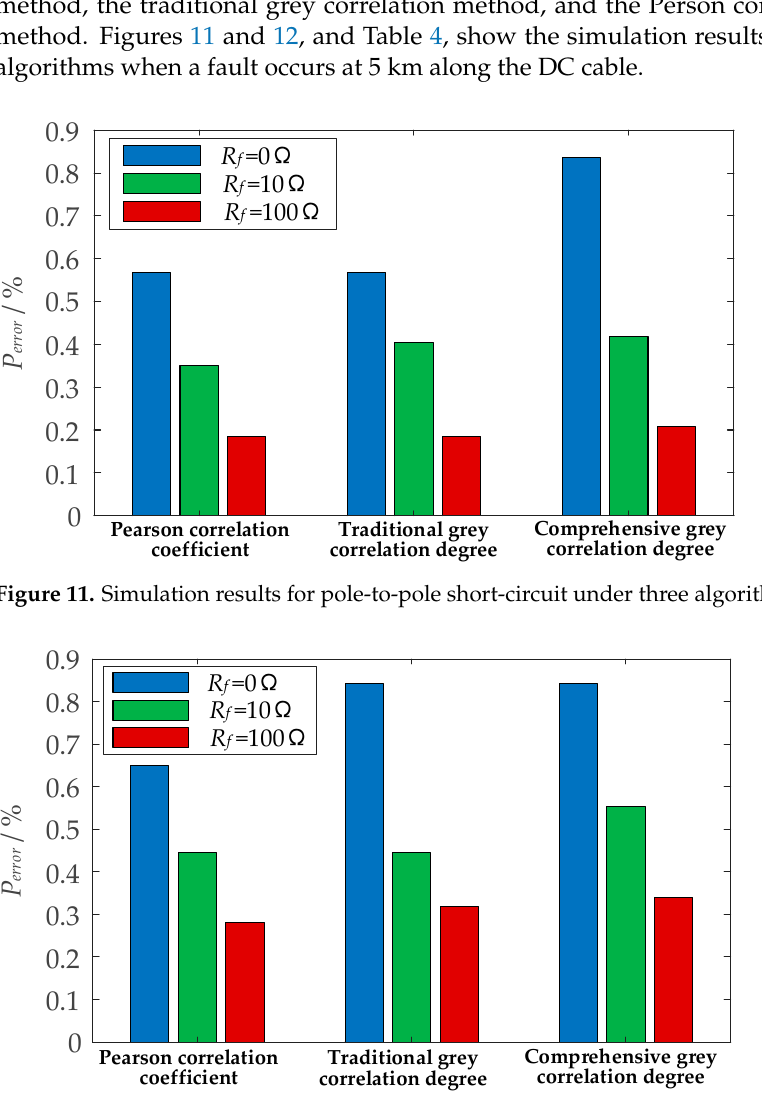
Table 4. Fault location results for three similarity algorithms.